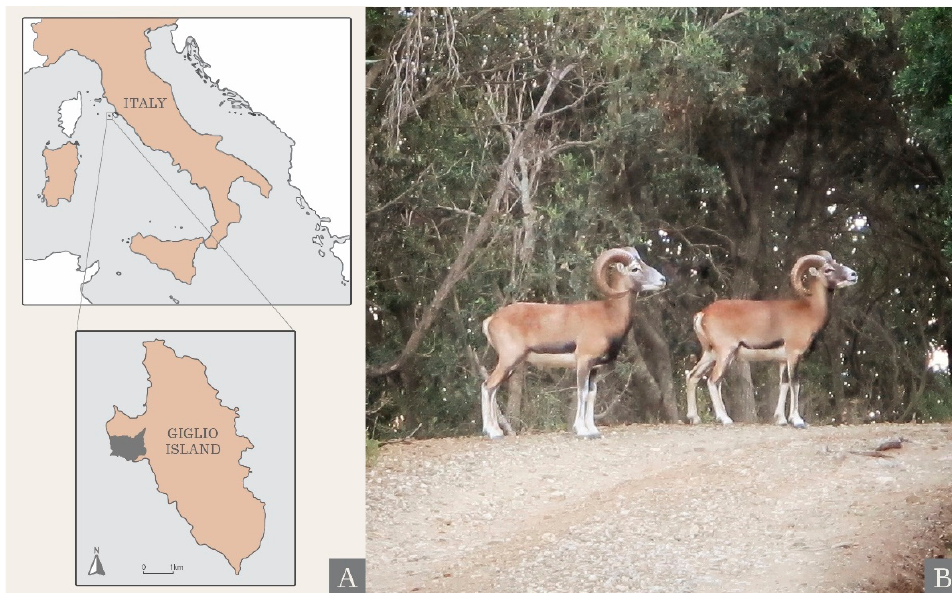
Figure 1. Geographic location of the Giglio Island. ( A ) The dark grey area represents the range of the original enclosure in the Franco promontory. ( B ) Two adult males of mouflon roaming in Franco promontory. Photo courtesy of Amy Bond, 2021.